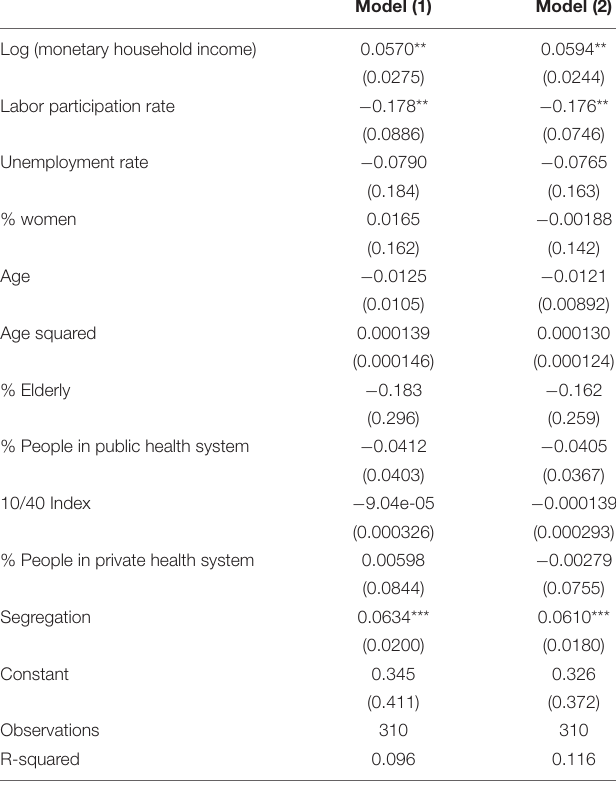
TABLE 3 | Proportion